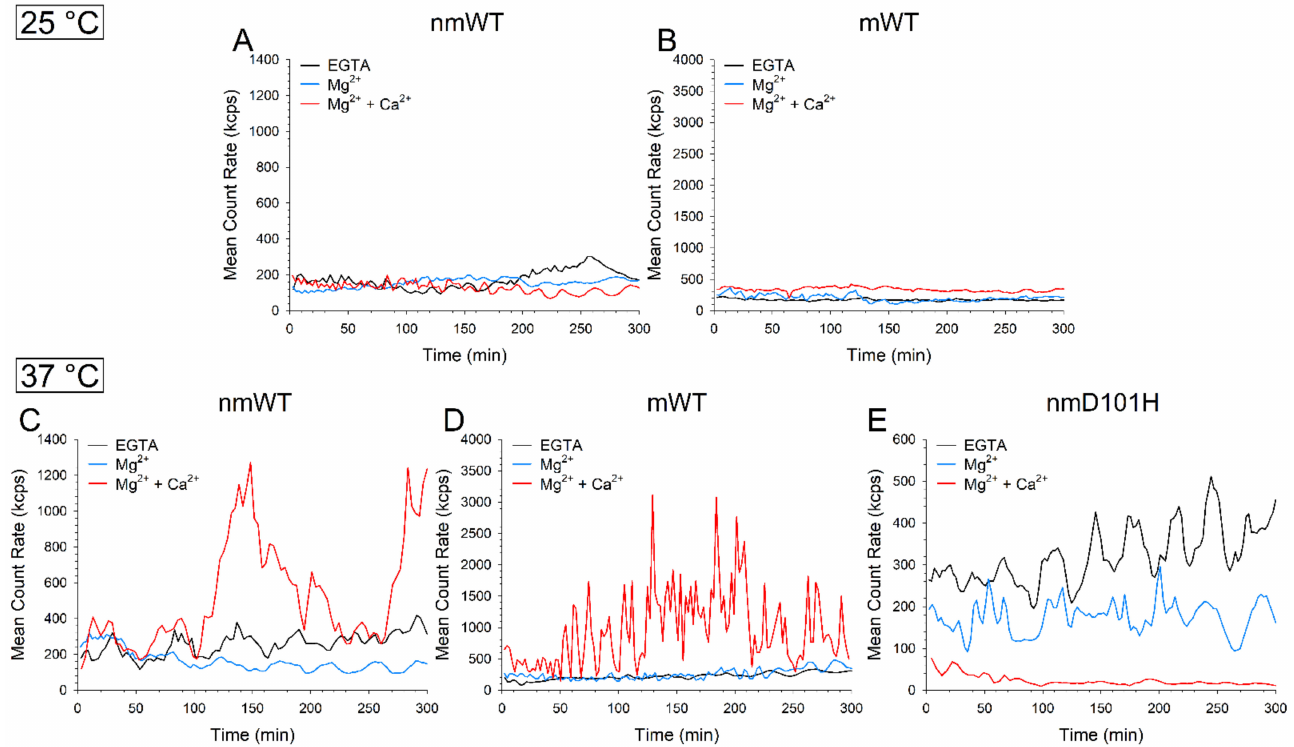
Figure 5. Time evolution over 5 h at 25 ◦ C of the mean count rate of ~8 µ M ( A ) nmWT; and ( B ) mWT GCAP3 in the presence of 500 µ M EGTA (black), 500 µ M EGTA and 1 mM Mg 2+ (blue), or 1 mM Mg 2+ and 500 µ M Ca 2+ (red). Time evolution over 5 h at 37 ◦ C of the mean count rate of ~8 µ M ( C ) nmWT; ( D ) mWT; and ( E ) nmD101H GCAP3 in the same experimental conditions as